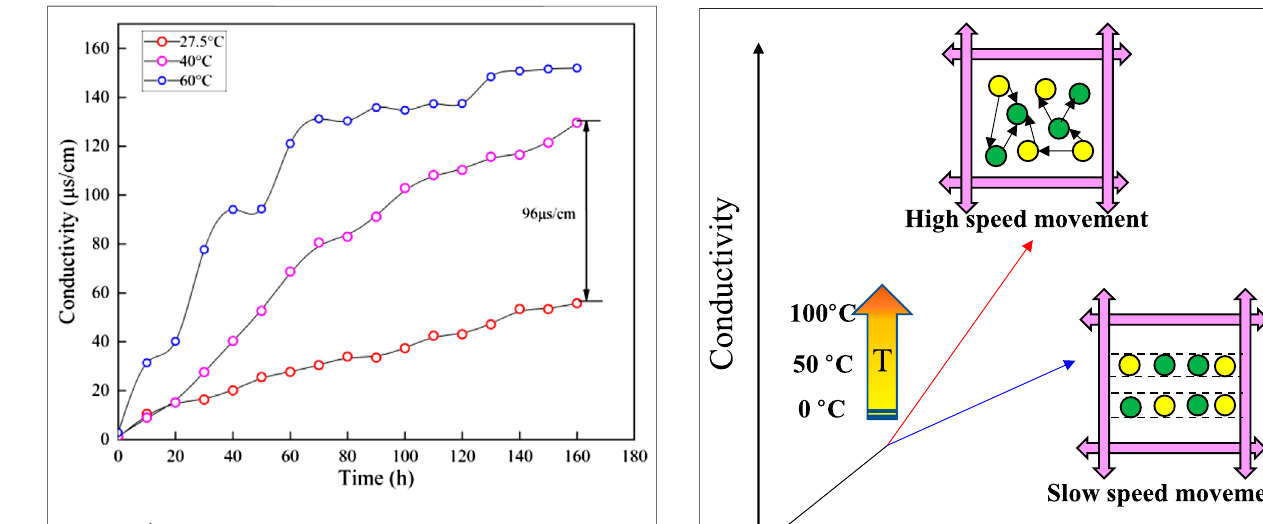
FIGURE 9 | The relationship between conductivity curves and temperature.